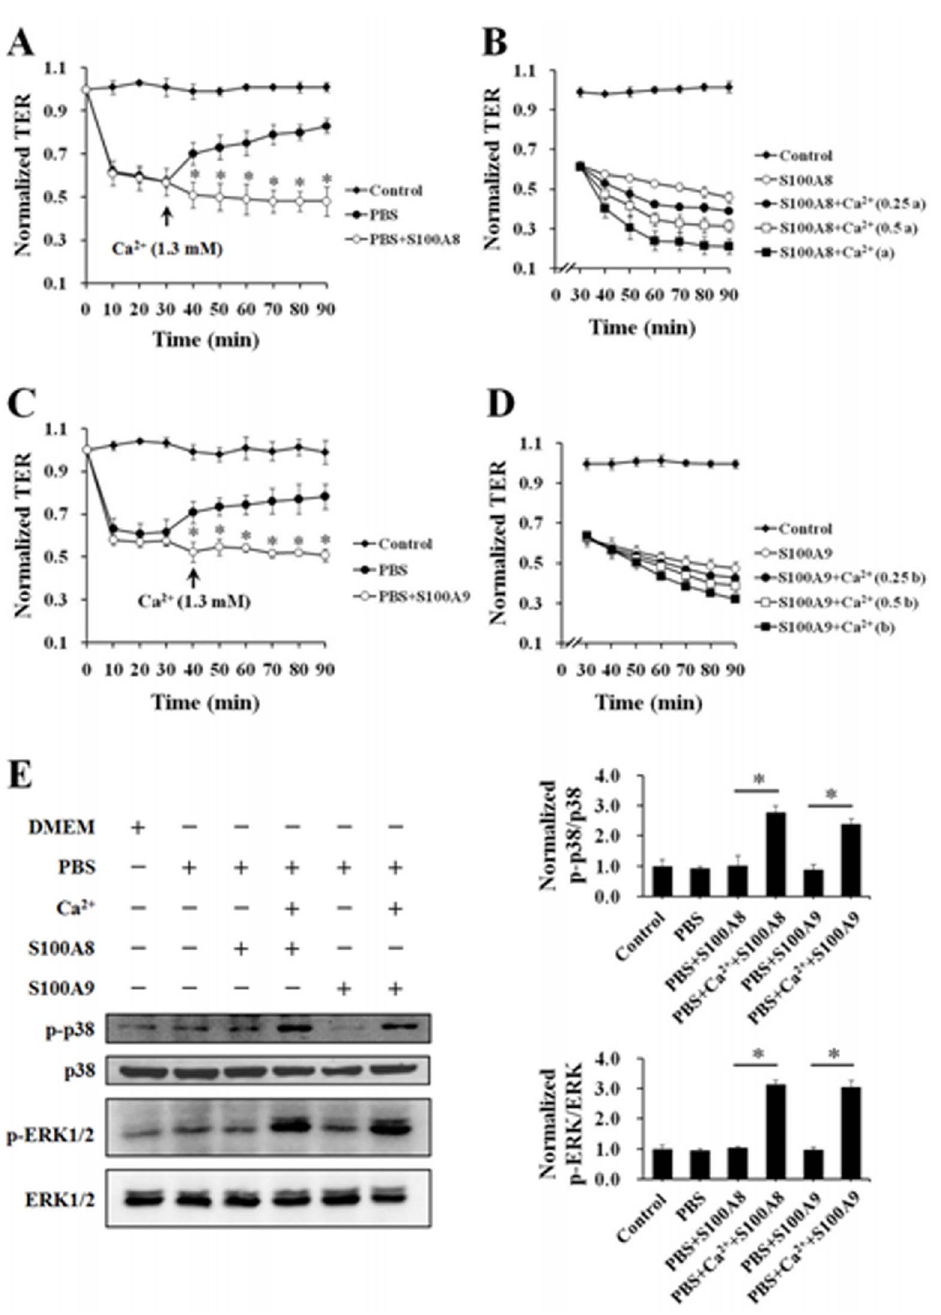
Figure 7. S100A8 and S100A9 increased HUVEC permeability in a Ca 2 + -dependent manner. ( A ) HUVECs were incubated with Ca 2 + -free medium (PBS) with and without S100A8 (2.0 m g/mL) for 90 min and at the 30th min 1.3 mM Ca 2 + were added to the medium. TER was measured every 10 min. All data are presented as mean 6 s.d. of four independent experiments. * P , 0.01 vs. PBS. ( B ) HUVECs were incubated with Ca 2 + free medium (PBS) for 30 min. Then HUVECs were stimulated with S100A8 (2.0 m g/mL) which was pre-incubated with different concentration of Ca 2 + (0, 0.25a, 0.5a and a. a=0.37 m M. ‘‘a’’ represents the concentration of Ca 2 + which can just saturate calcium binding sites of 2.0 m g/mL S100A8) for 60 min. TER was measured every 10 min. All data are presented as mean 6 s.d. of four independent experiments. ( C ) HUVECs were incubated with Ca 2 + -free medium (PBS) with and without S100A9 (2.0 m g/mL) for 90 min and in the 30th min 1.3 mM Ca 2 + were added to the medium. TER was measured every 10 min. All data are presented as mean 6 s.d. of four independent experiments. * P , 0.01 vs. PBS. ( D ) HUVECs were incubated with Ca 2 + free medium (PBS) for 30 min. Then HUVECs were stimulated with S100A9 (2.0 m g/mL) which was pre-incubated with different concentration of Ca 2 + (0, 0.25b, 0.5b and b. b=0.30 m M, ‘‘b’’ represents the concentration of Ca 2 + which can just saturate calcium binding sites of 2.0 m g/mL S100A9) for 60 min. TER was measured every 10 min. All data are presented as mean 6 s.d. of four independent experiments. ( E ) HUVECs were stimulated with S100A8 (2.0 m g/mL) and S100A9 (2.0 m g/mL) with or without Ca 2 + . Phosphorylation of p38 (p-p38) and ERK1/2 (p-ERK1/2) were assessed by Western blotting with specific antibodies as described in Materials and Methods. The ration of immunointensity between the phosphorylation of MAPKs (p-p38 and p-ERK) and total MAPKs (p38 and ERK) were calculated. The results are expressed in mean 6 s.d. from three independent experiments. * indicates P , 0.01.